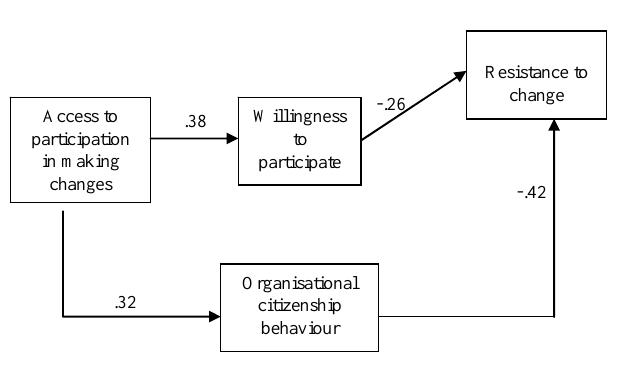
Figure 2: Revised model - Extra-role performance, participation and resistance to